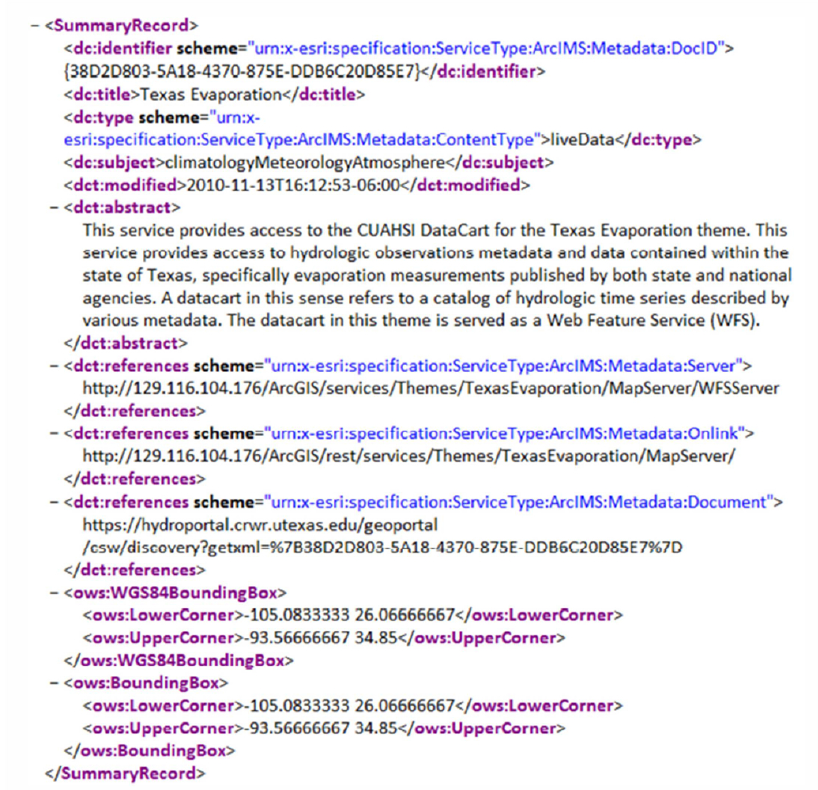
Fig. 12. Example record within HydroPortal via its CSW interface (Seppi, 2010).